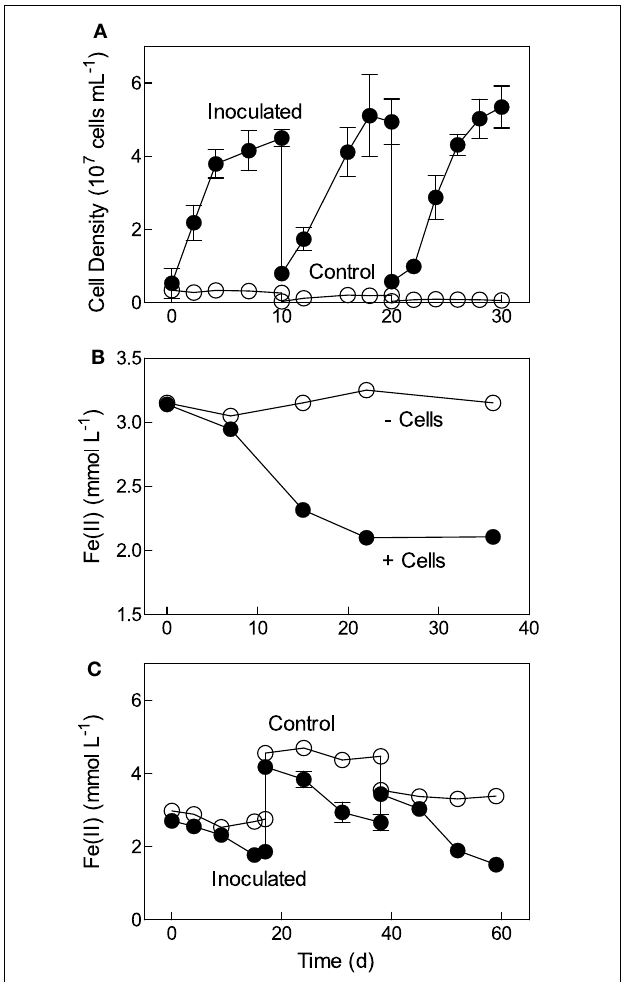
FIGURE 2 | Fe(II) oxidation by Bradyrizobium sp. strain 22: (A) Repeated growth in aerobic FeCl2 medium; (B) aerobic oxidation of biotite (inoculum grown previously several times in aerobic biotite medium); (C) repeated growth in reduced NAu-2/nitrate medium. Data in panel A show the mean ± SD of five replicate cultures; data in panel (B) represent the results from a single culture that had been transferred several times in identical medium before conducting this experiment; data in panel (C) show the mean ± SD of triplicate cultures.